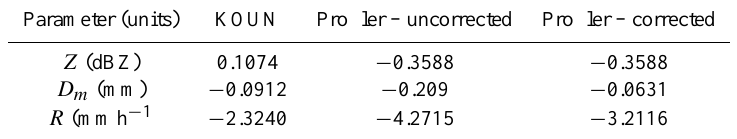
Table 5. Bias of retrieved parameters relative to 2DVD observations from 11 March squall line.